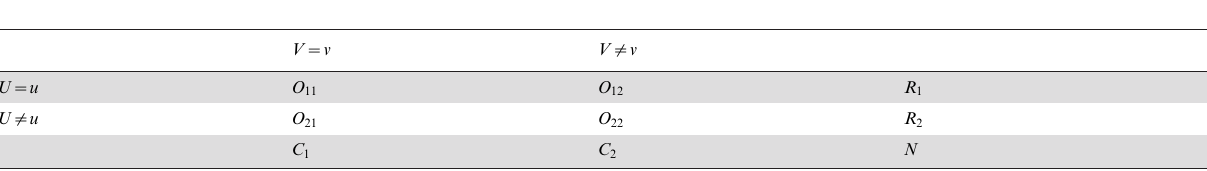
Table 1. Contingency table of observed frequencies for pairs of MeSH descriptors.